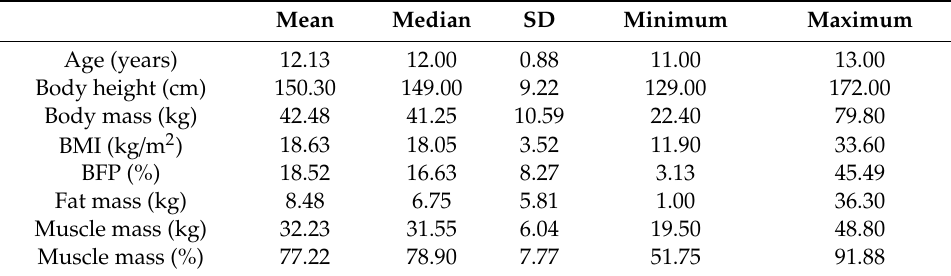
Table 1. Anthropometric parameters and body mass